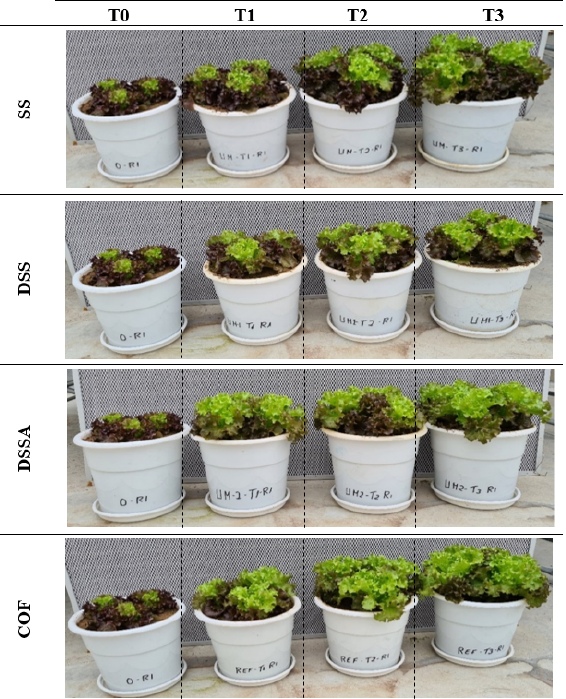
Figure 1. Growth of lettuce by the end of the experiment for testing four treatments (T0 to T3) and four soil amendment materials (SS, DSS, DSSA, and COF). Visually, it is possible to state that all treatments have better productivity than T0, independently of the material used, which is corroborated by the results in Figure 2 ( p < 0.05). In general, the productivity of fresh lettuce ranged from approximately 44 ± 1 g/pot in T0 to 140 ± 1 g/pot in T3 for SS, DSSA, and COF. Thus, the productivity is around 3.2 times higher in T3 than in T0. DSS revealed small productivities in T2 and T3 compared to the others ( p < 0.05) but still 1.3 times higher in T3 (100 ± 2 g/pot) than in T0 (44 ± 1 g/pot). These small productivities observed in T3 (compared to T1 and T2) for DSS do not represent a problem since the system is in extreme conditions in this treatment. Indeed, the increase in the application rate of the materials can lead to toxicity, increased salinity, nutritional imbalance, pH change, and other problems that can affect the proper growth of the crop. These differences can be due to physical, chemical, and biological effects on the different added materials or even the initial crop quality. Regardless, DSS exhibited similar productivity to SS and DSSA in T1 while it had the great advantage of not contain- ing pathogens compared to SS. DSSA showed a consistent performance for all treatments with productivities ranging from 83 to 143 g/pot from T1 to T3. Thus, the use of GLD during the drying process is advantageous from a technical point of view and the final product. The values on dry weight led to the same conclusions.